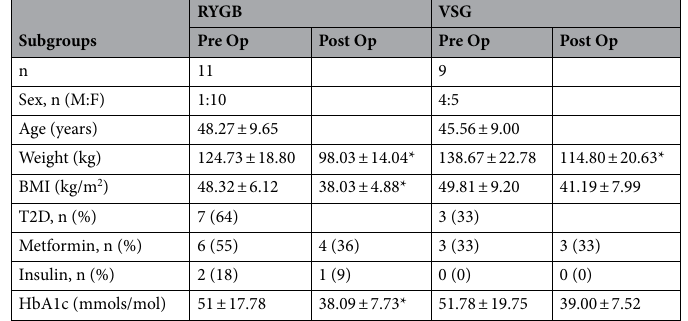
Table.2. Effect of surgery by surgical procedure subgroups. *p < 0.05 pre- and post-op comparison.